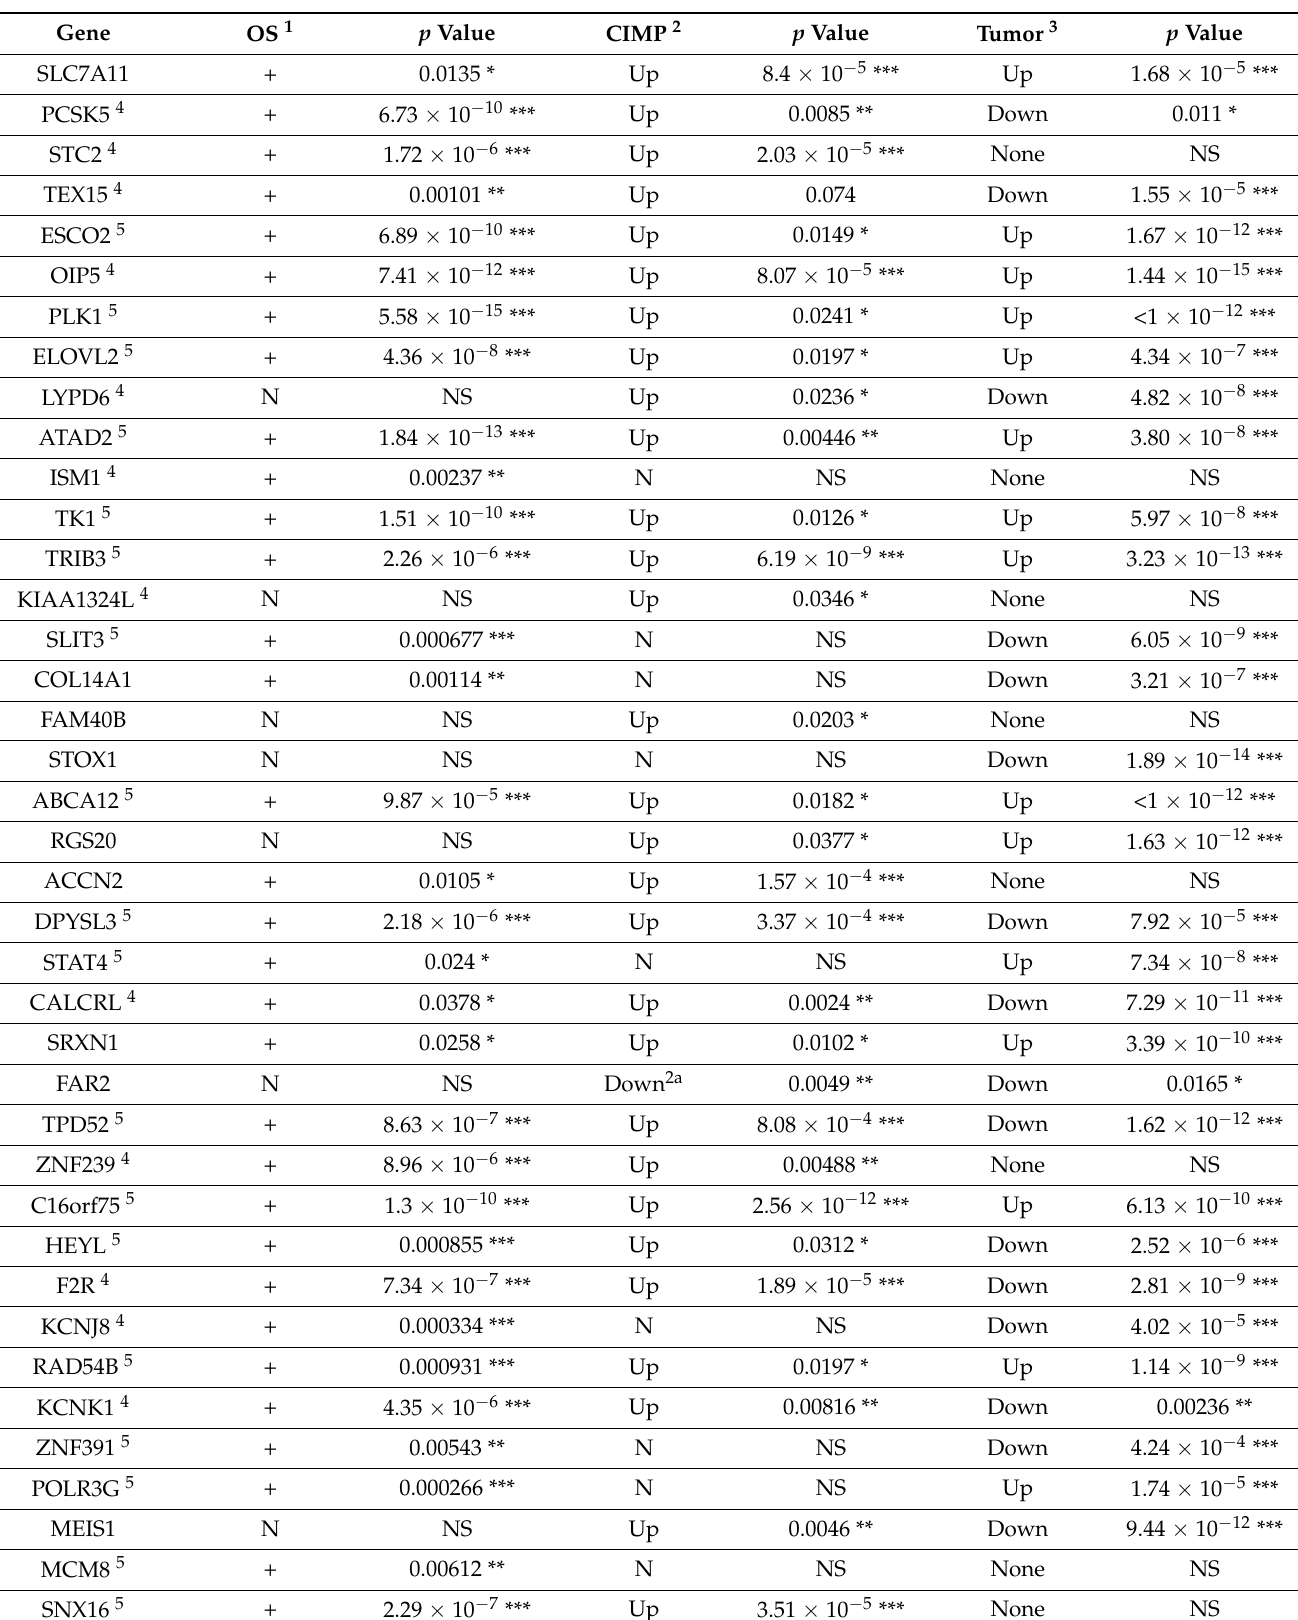
Table 2. Characterization of Overlap66